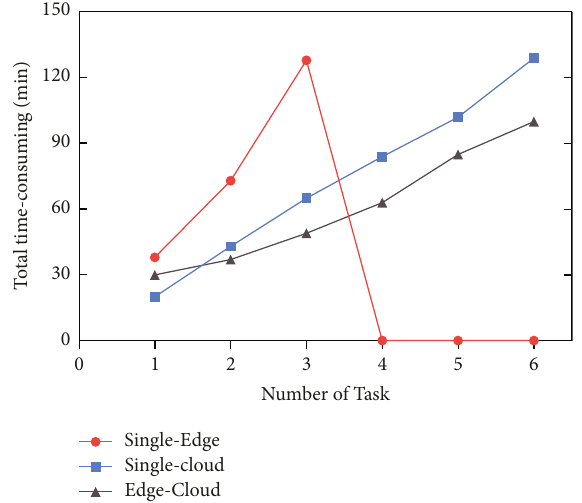
Figure 5: Comparison of the total time-consuming of the three schemes under the same number of tasks.